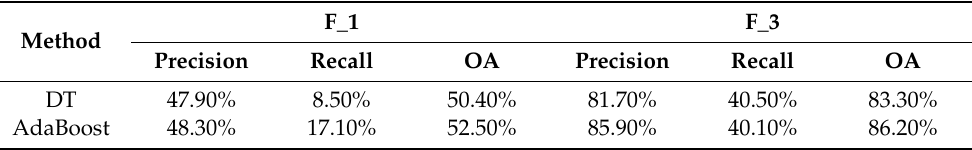
Table 4. Recall of Feature Gr under different combination